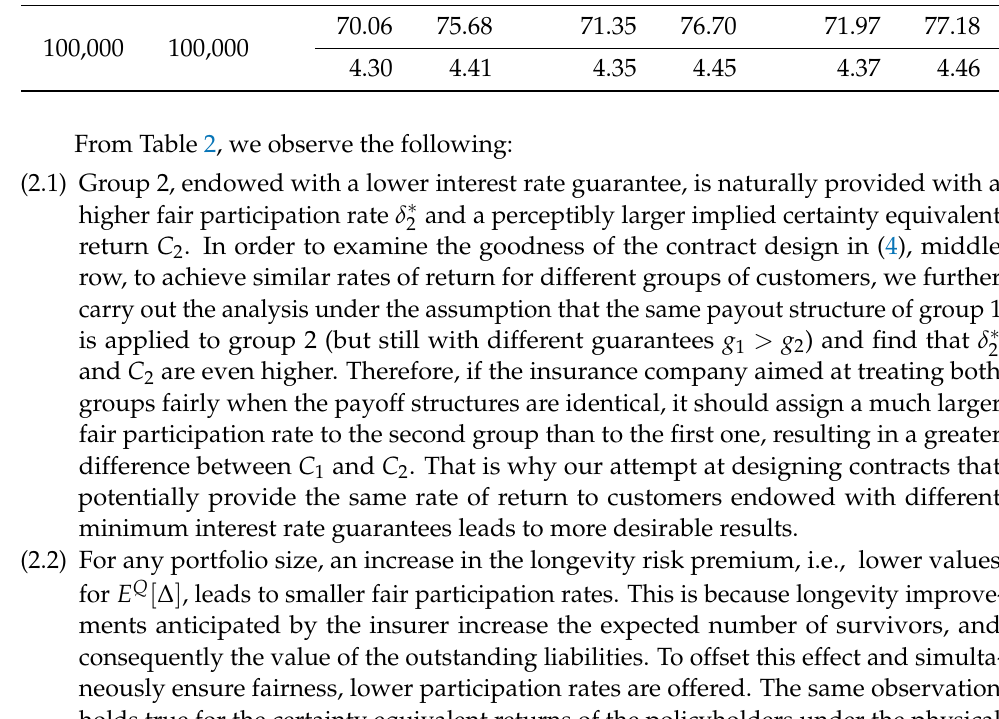
Table 2. Fair participation rates and certainty equivalent returns for Case 1 with T = 12, different portfolio sizes with N 1 ( 0 ) = N 2 ( 0 ) and different values of E Q [ ∆ ] . All results are in percentage. T = 12 E Q [ ∆ ] =